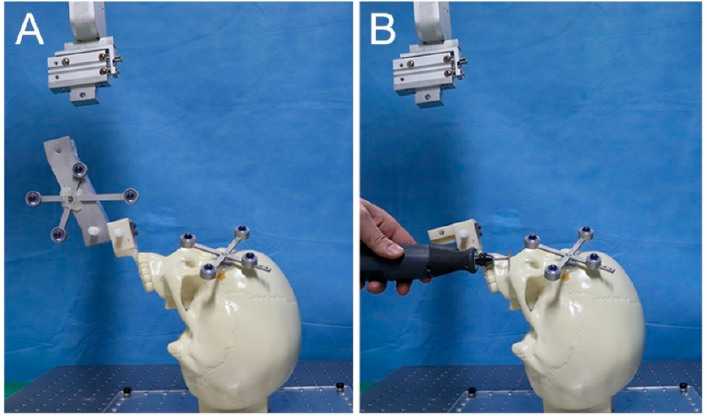
Figure 3. Preoperative registration for matching the physical space and the CT image space. ( A ) Registration body; ( B ) acquisition of the physical positions of spheres on the registration body related to the tracking tool on the end-effector. Figure 4. Initial intraoperative registration of the preoperative maxillary position ( A ) and Le Fort Ⅰ osteotomy ( B ).